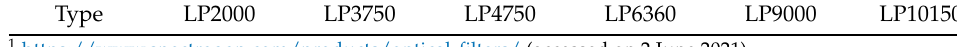
Figure 2. ( a ) Physical view of broadband infrared spectral imaging system; ( b ) Rendering picture of broadband infrared spectral imaging system. Table 1. The filters of this device 1 .